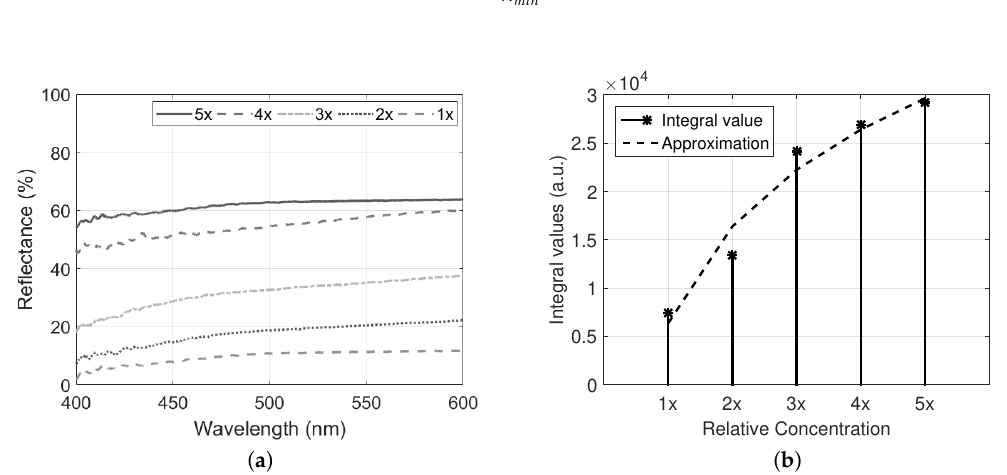
Figure 5. ( a ) Reflectance of volcanic ash at different concentrations. ( b ) Integral results over the measured spectral